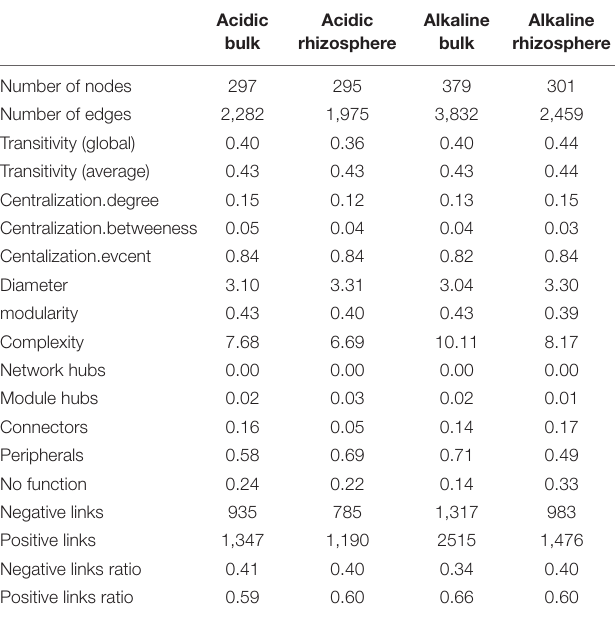
TABLE 2 | Topological features of the microeukaryotic co-existence networks in acidic bulk, acidic rhizosphere, alkaline bulk, and alkaline rhizosphere